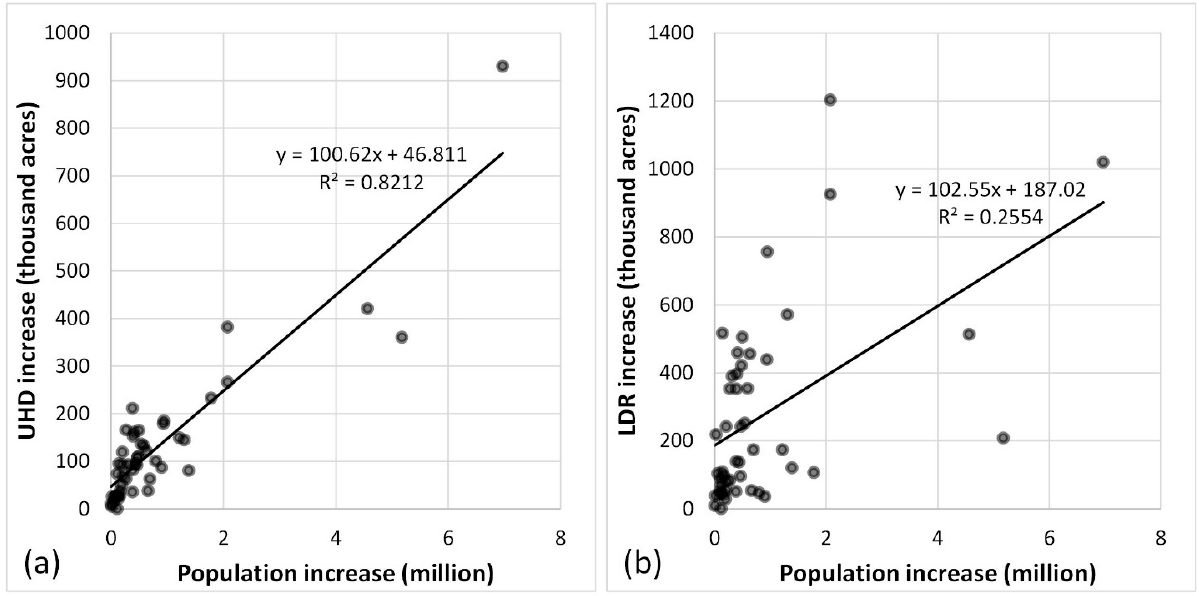
Figure 2. State-level relationship between population growth and urban area increases from 2001 to 2016 (( a ) urban and highly developed; ( b ) low-density residential).